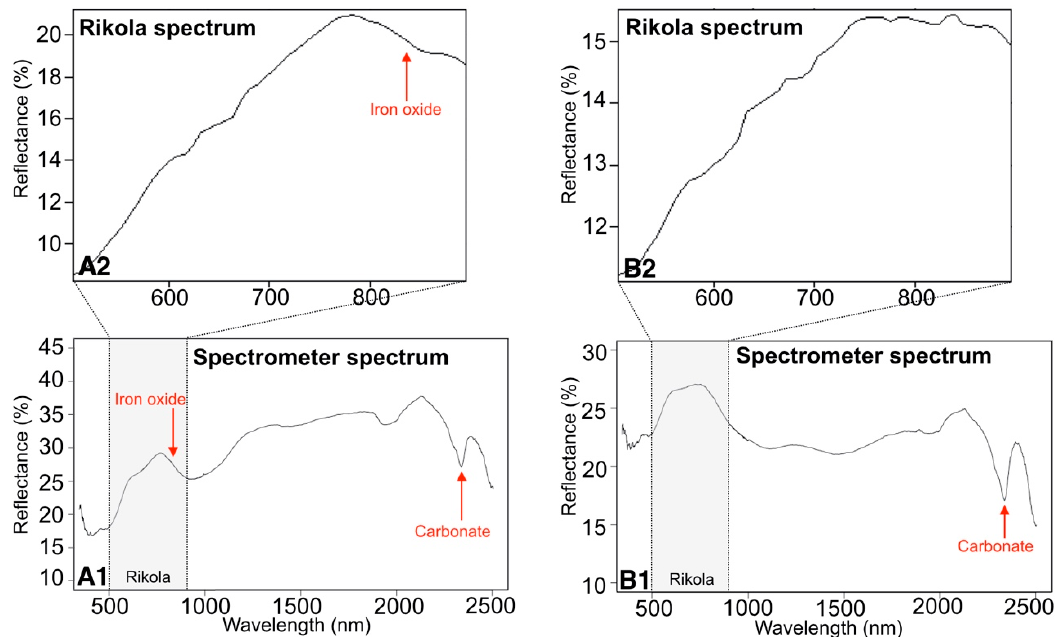
Figure 14. Diagram showing spectra taken by the portable spectrometer compared with spectra taken by the Rikola of D1 and D2 at validation points 1 and 2 respectively. ( A1 ) Spectrometer spectrum of Dyke 1 showing a carbonate absorption feature as well as an iron oxide feature. ( A2 ) Rikola spectrum of Dyke 1 at the same point also showing an iron oxide feature. ( B1 ) Spectrometer spectrum of Dyke 2 showing a carbonate absorption feature. ( B2 ) Rikola spectrum of Dyke 2 at same point.